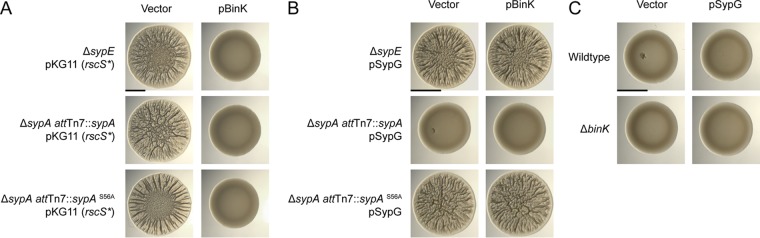
pSypG is epistastic to BinK, and BinK signaling is independent of SypE-SypA. (A) Wrinkled colony formation in the ΔsypE, ΔsypA attTn7::sypA, and ΔsypA attTn7::sypAS56A strains carrying the plasmid pKG11 (rscS*) is inhibited upon overexpression of BinK. Wrinkled colony formation was assessed on LBS-tetracycline (Tet)-kanamycin (Kan). (B) Wrinkled colony formation in the ΔsypE, ΔsypA attTn7::sypA, and ΔsypA attTn7::sypAS56A strains carrying the plasmid pSypG (pEAH73) is not inhibited upon overexpression of BinK. Wrinkled colony formation was assessed on LBS-Tet-Kan. (C) Wrinkled colony formation is not observed in the wild-type or ΔbinK strains carrying the plasmid pSypG (pEAH73). Wrinkled colony formation was assessed on LBS-Tet. All images were taken 48 h postspotting. Bars, 0.5 cm.